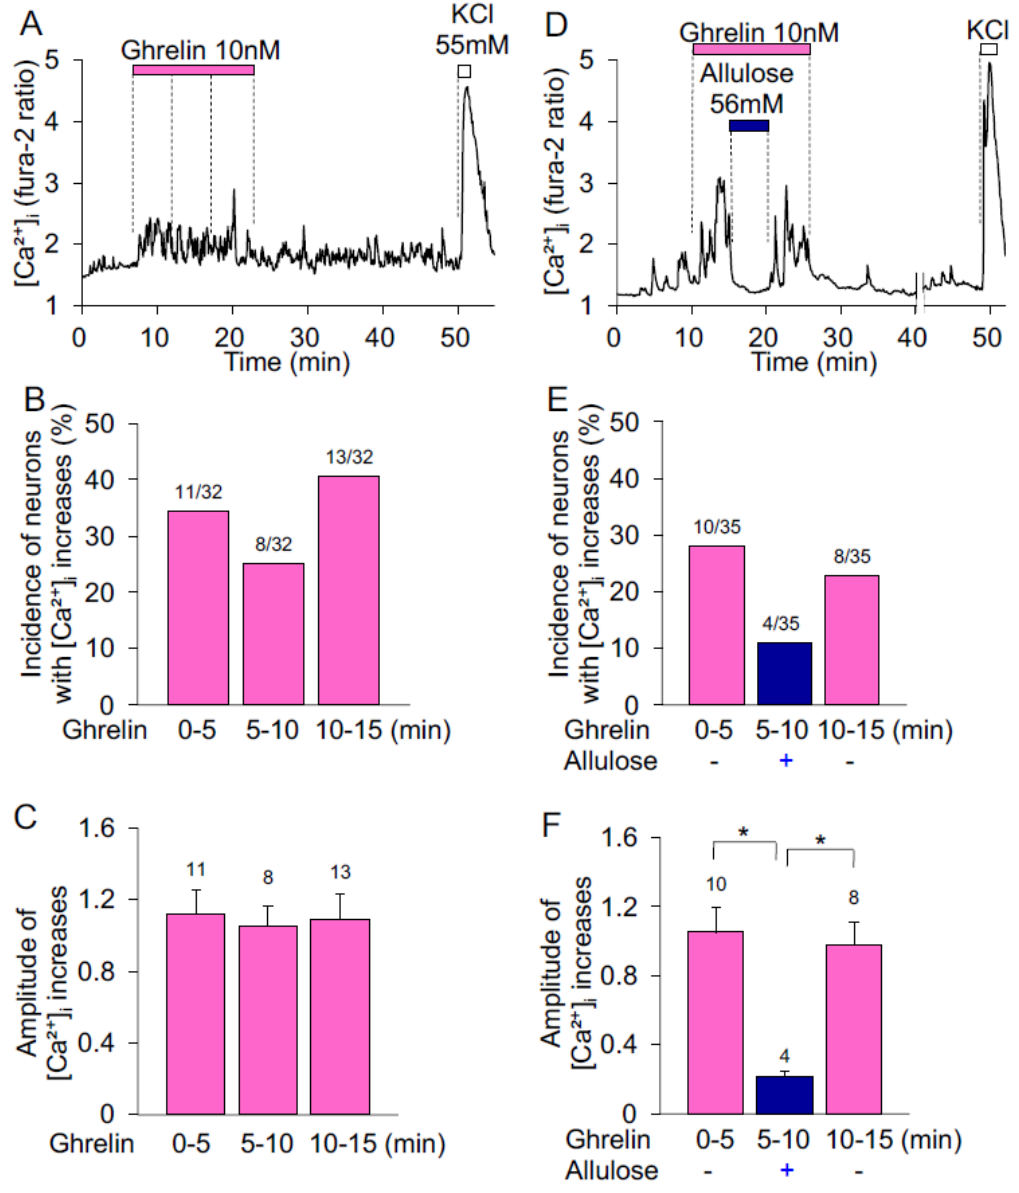
Figure 1. Effects of D -allulose on ghrelin-induced [Ca 2 ⁺ ] i increases in ARC neurons. [Ca 2 ⁺ ] i was measured in single neurons isolated from the hypothalamic ARC. Single neurons were superfused with HKRB containing 2 mM glucose. ( A ) Ghrelin (10 nM) was given for continuous 15 min. [Ca 2 ⁺ ] i started to increase during the first 0–5 min and continued to be increased during the middle 5–10 min and last 10–15 min periods of 15 min exposure to ghrelin. This neuron subsequently responded to KCl with an increase in [Ca 2 ⁺ ] i . ( B ) Incidence of neurons with [Ca 2 ⁺ ] i increases during the first, middle and last periods of 15 min ghrelin exposure. The numbers above each bar indicate the number of neurons that showed [Ca 2 ⁺ ] i increases in response to ghrelin over that examined. ( C ) Amplitude of [Ca 2 ⁺ ] i increases during the first, middle and last periods of 15 min ghrelin exposure. Data are presented as mean ± SEM. No significant difference between groups by one-way ANOVA followed by Tukey’s test. ( D ) D -allulose was simultaneously administered in the middle period of 15 min ghrelin exposure. The ghrelin-induced [Ca 2 ⁺ ] i increase was inhibited by simultaneous administration of D -allulose in the middle period, and subsequently restored after washing D - allulose in the last period. This neuron responded to KCl with an increase in [Ca 2 ⁺ ] i . ( E ) Incidence of the neurons with [Ca 2 ⁺ ] i increases in response to ghrelin in the absence (first and last periods) and presence (middle period) of D -allulose. The numbers above each bar indicate the number of neurons that showed [Ca 2 ⁺ ] i increases in response to ghrelin over that examined. ( F ) Amplitude of [Ca 2 ⁺ ] i increases in response to ghrelin in the absence (first and last periods) and presence (middle period)